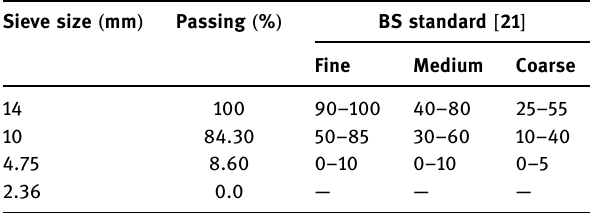
Table 3: Sieve analysis of the used coarse aggregate Sieve size ( mm )